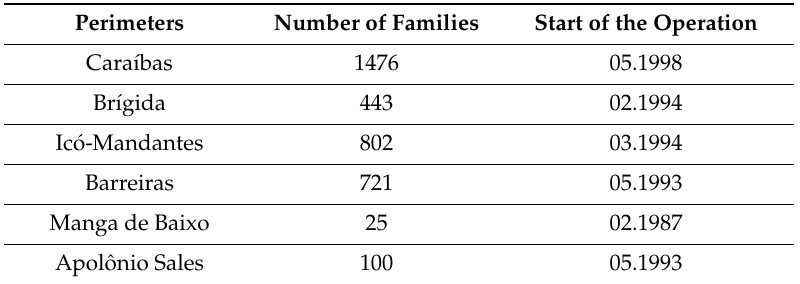
Table 4. Irrigation perimeters of the Itaparica System located in the State of Pernambuco.